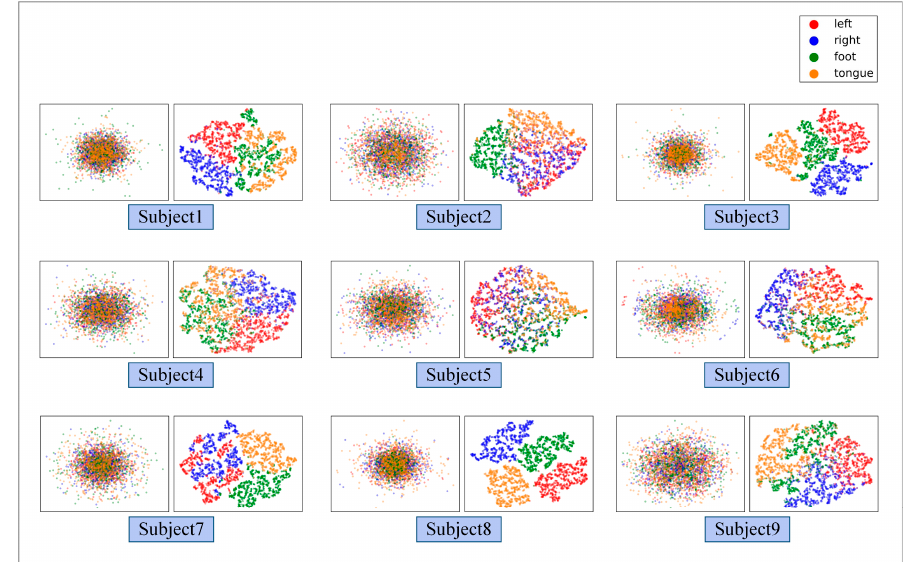
Figure 10. The scatter plot of the feature distribution of 9 subjects under the GCFN model. As shown in Figure 11, the confusion matrices of different models are used for evaluation. In the figure, the diagonal lines represent the global classification accuracy of various tasks, and precision and recall rate are included. As shown in the figure, the re- call rate of the left hand, right hand, foot, and tongue in the GCFN model is 82.2%, 77.6%, 83.0%, and 80.0%, respectively. The recall rate of the four classes of MI tasks in the proposed model is higher than those of the other two models. In addition, the preci- sion of the GCFN model is 79.3% for the left hand, 80.2% for the right hand, 80.9% for the foot, and 82.8% for the tongue. In terms of precision, GCFN also performs better than the other two models.